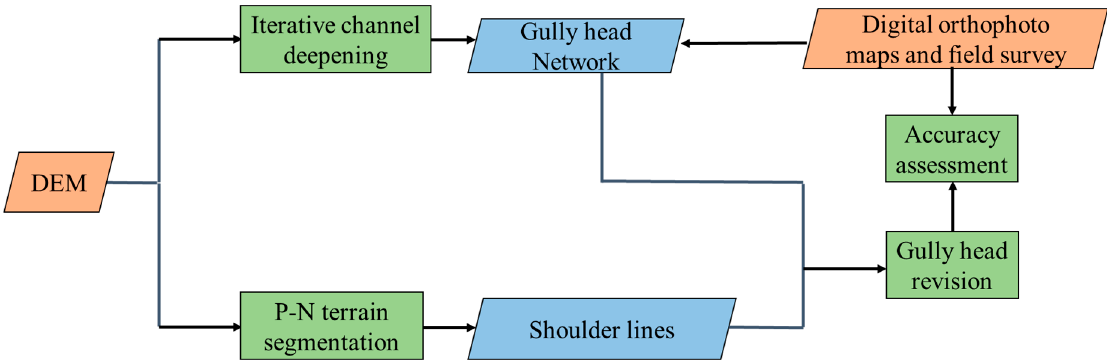
Figure 7. Workflow of the gully head extraction.